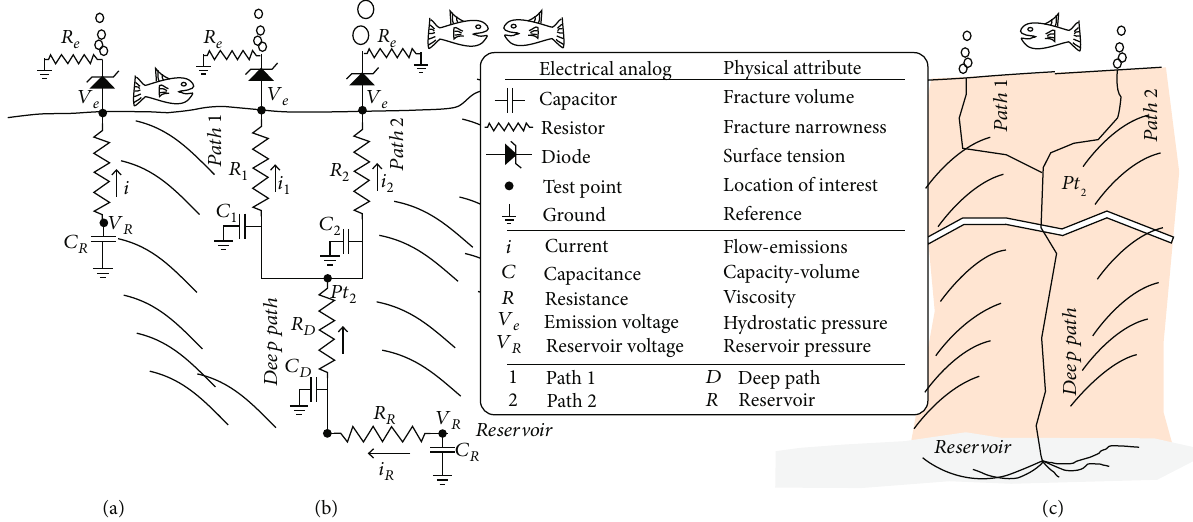
Figure 3: Seep electrical model for a simple seep area. Table de fi nes the physical seep fl ow process and corresponding electrical component. Adapted from Leifer and Wilson